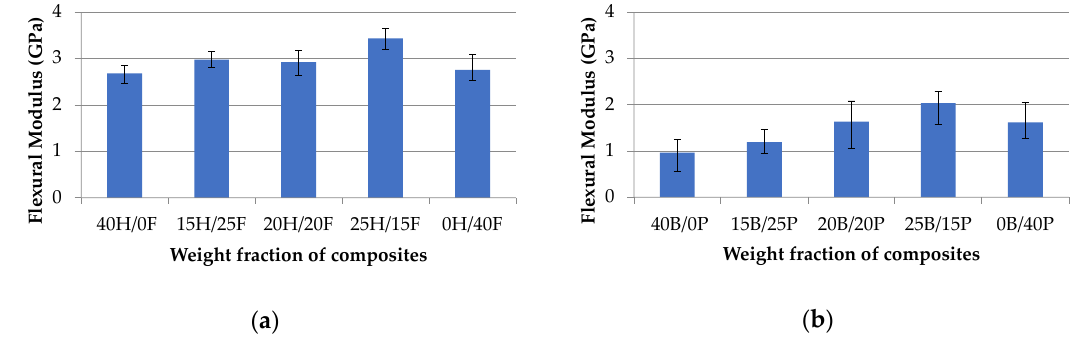
Figure 8. Flexural modulus vs. weight fraction of H/F composites ( a ) and B/P composites ( b ).